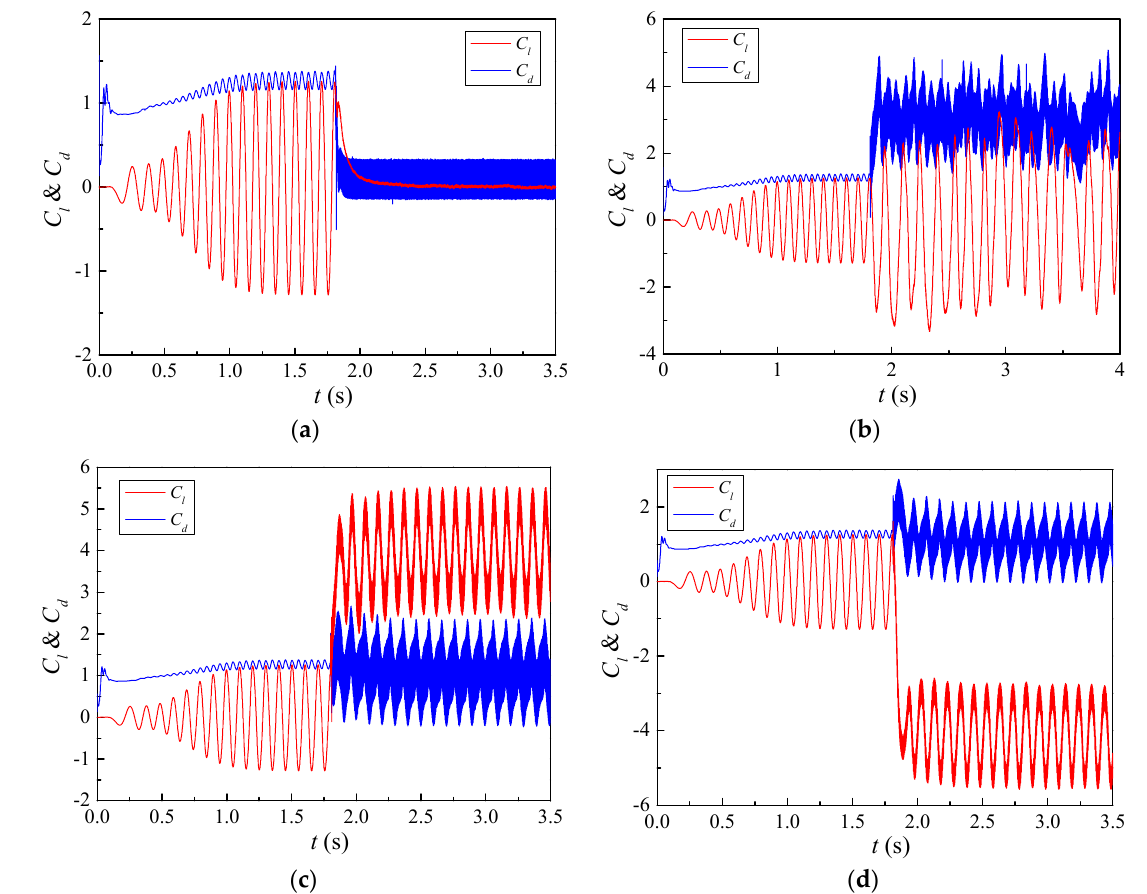
Figure 5. Lift and drag coefficient time history curves under various propagation directions. ( a ) Downstream. ( b ) Upstream. ( c ) Corotating-Clockwise. ( d ) Corotating-Counterclockwise.